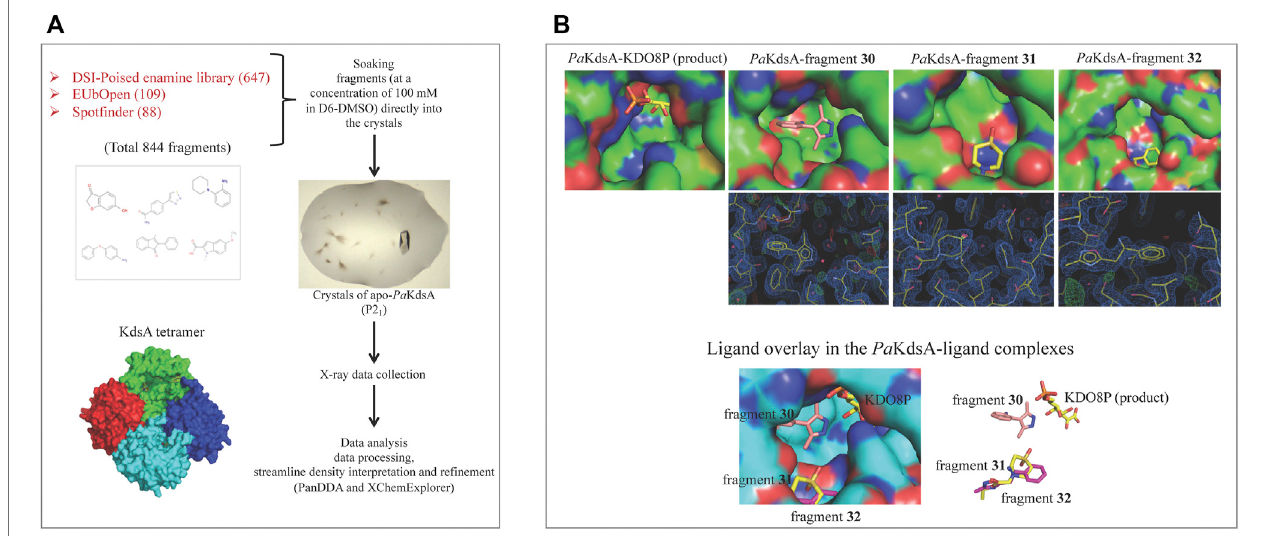
FIGURE 12 | FBDD campaign against Pa KdsA (A) Crystal-based fragment screening against Pa KdsA at the XChem facility of the Diamond Light Source. (B) Fragment hits ( 30 , 31 and 32 ) obtained from the screening. The top panel shows location of fragments and the product KDO8P in their respective complexes with Pa KdsA. The middle panel shows the electron density maps of fragments and the bottom panel shows the fragments from their complexes to Pa KdsA mapped on the Pa KdsA-KDO8P complex in order to compare their locations in the active site of Pa